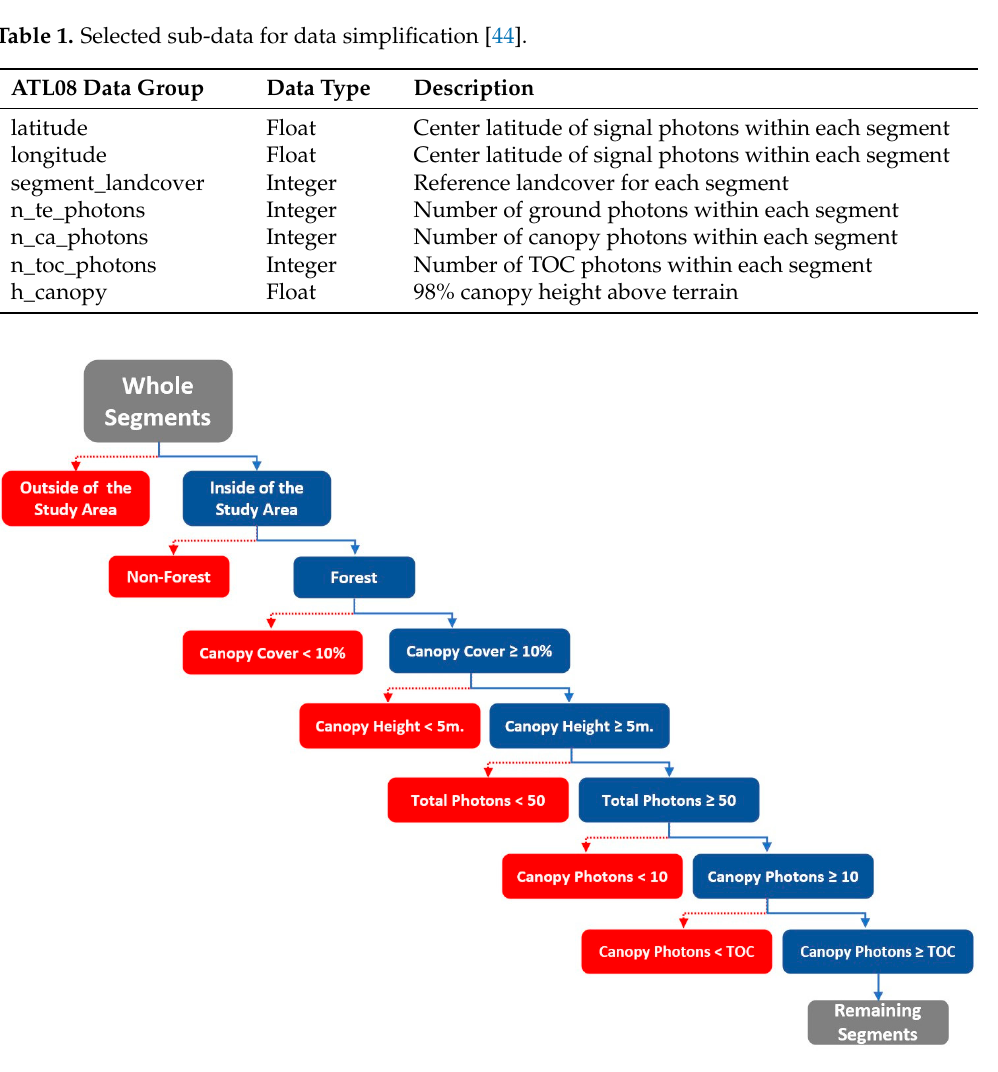
Table 1. Selected sub-data for data simplification [44].